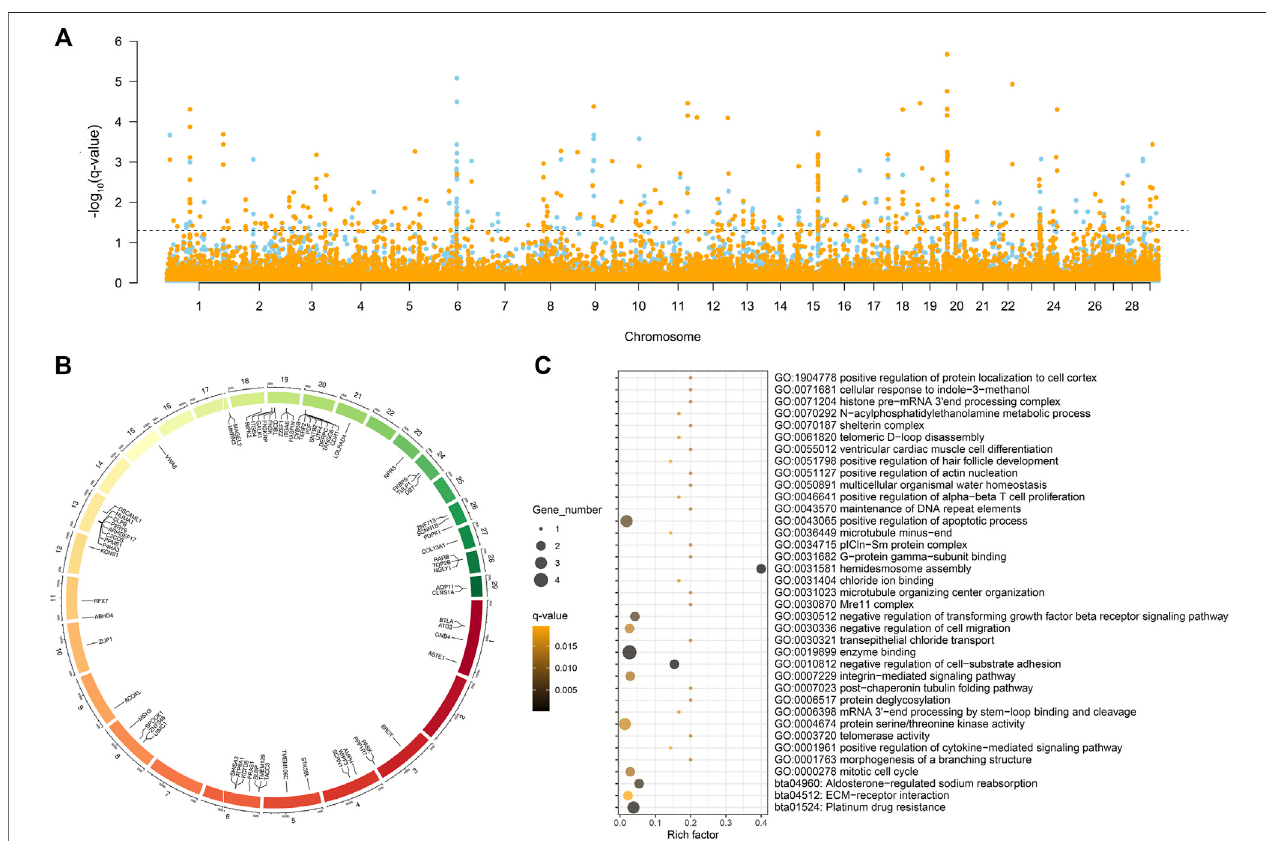
FIGURE 3 | (A) Manhattan plot of decorrelated composite of multiple signals q -values of NTWY (skyblue) and LTWY (yellow) populations. (B) Overlapping genes identi fi ed by DCMS method between NTWY and LTWY. (C) Functional enrichment analysis of overlapping genes.